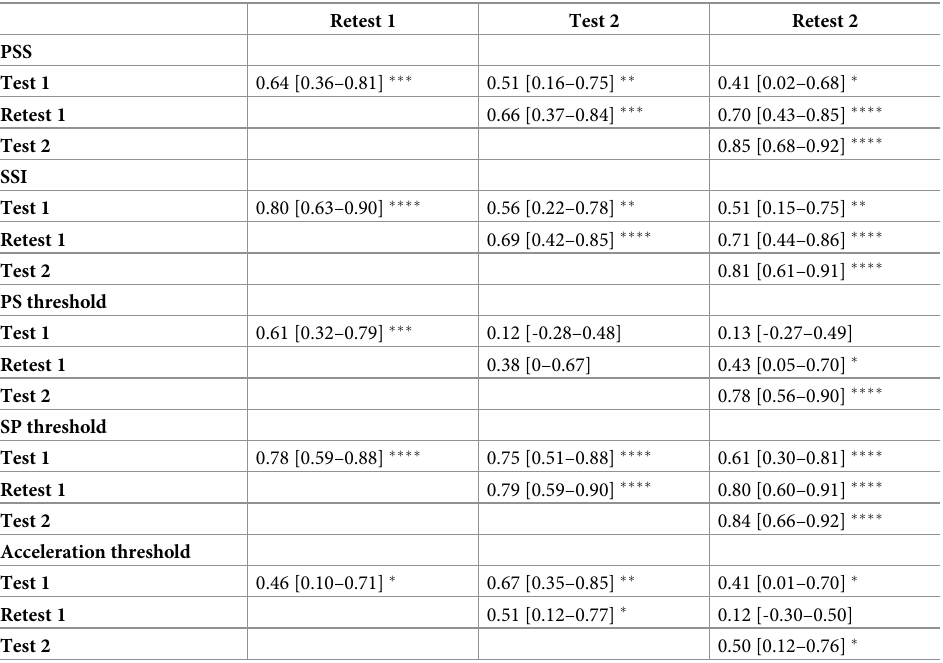
Table 2. Pearson correlation matrix for test-retest in the 2 trials.